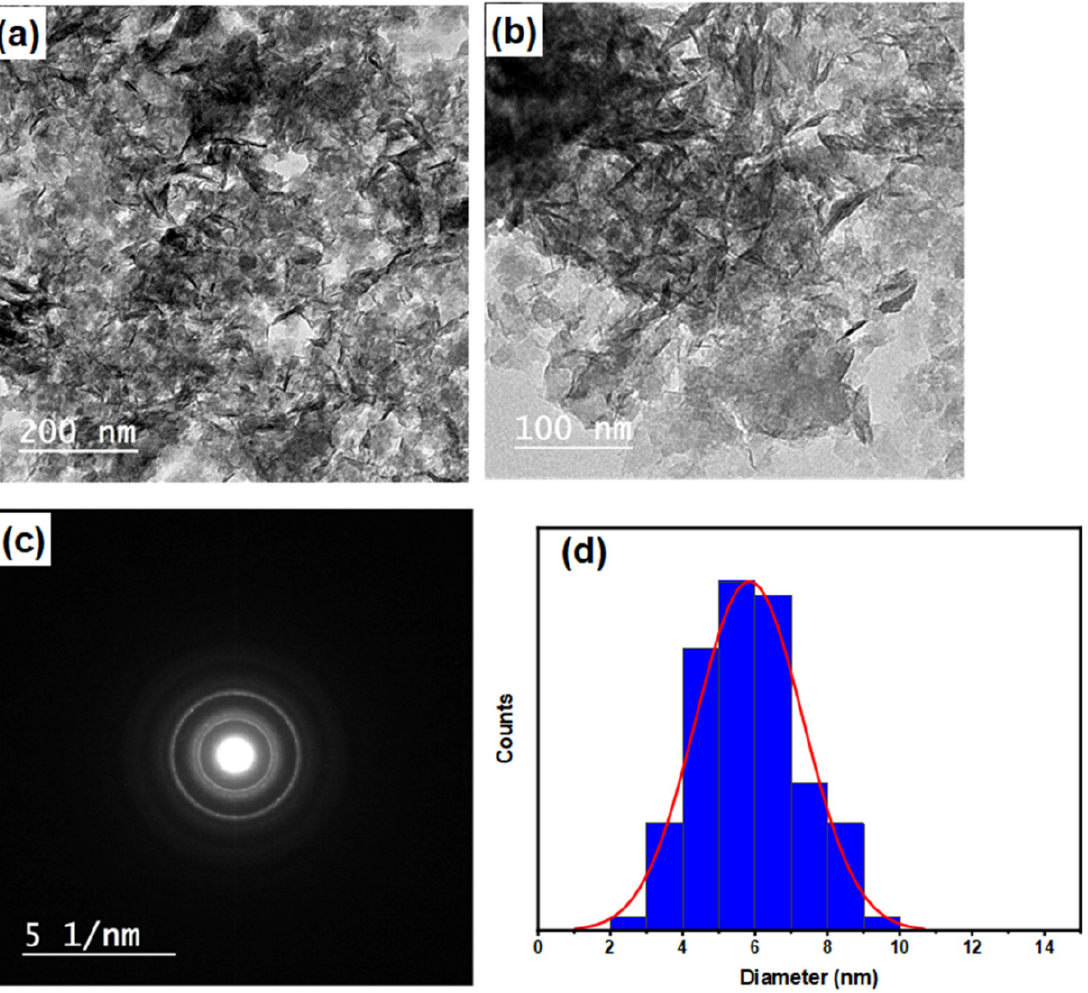
Figure 3. ( a , b ) HR-TEM images ( c ) SAED pattern and ( d ) particle size distribution calculated from TEM for β -Ni(OH) 2 nanoparticles.